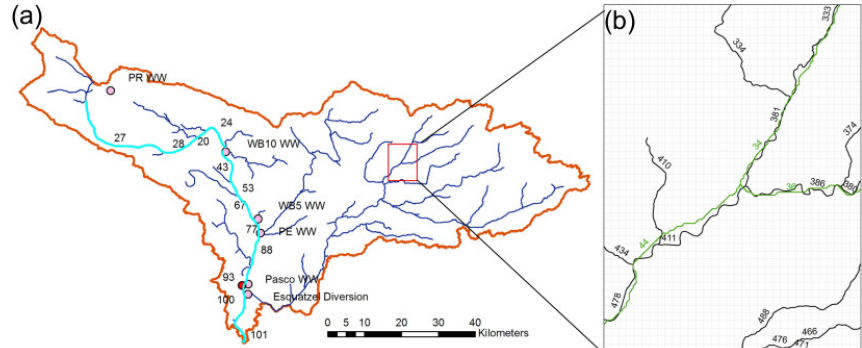
Figure 2. Reaches created by SWAT. The main channel of the Columbia River is highlighted in cyan (a) . Numbers identify the individual reaches, the red circle is the area where field samples for dissolved organic carbon were collected, pink circles are the main wasteways carrying irrigation return flow water from farms and irrigation system operations, and the red rectangle shows the selected location for the mapping between SWAT and NHD Plus v2 that is used for NEXSS simulation. Panel (b) shows the mapping between NEXSS (black lines) and SWAT (green lines) for the rectangle area. The numbers in (b) are reach